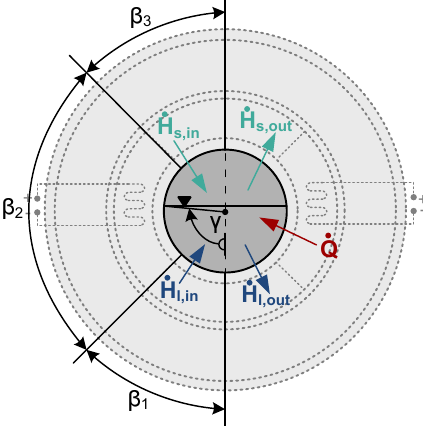
Figure 5. Sub-model: Ruths steam storages